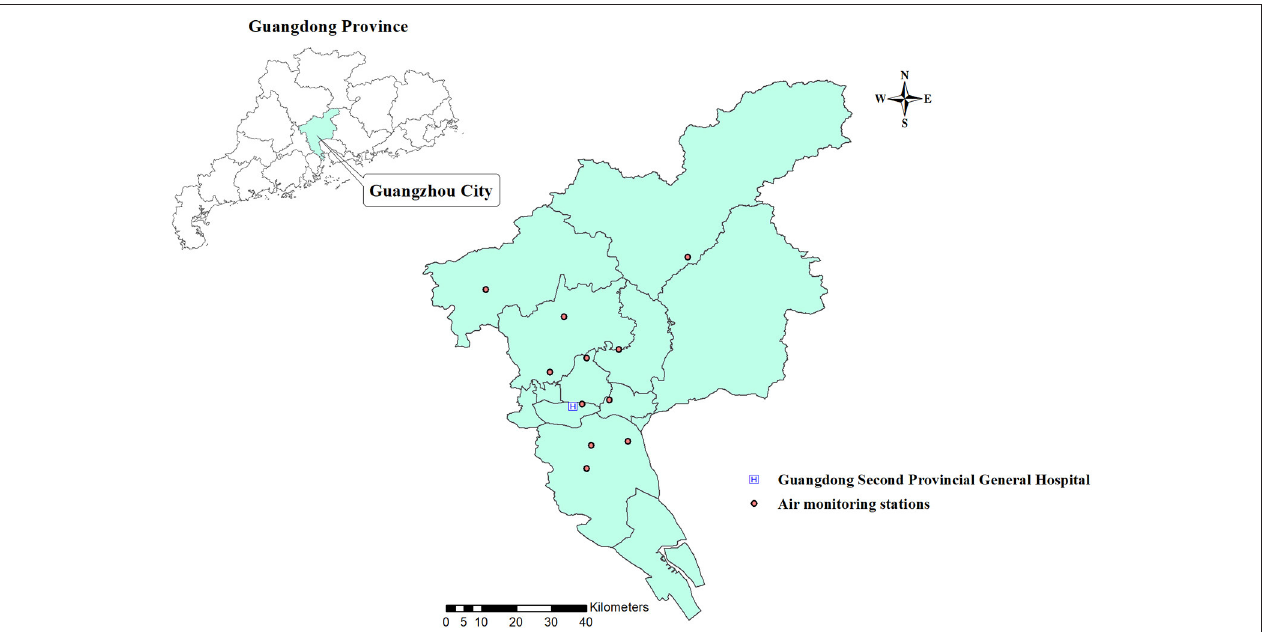
FIGURE 1 | Geographical distribution of the sample hospitals and air monitoring stations.